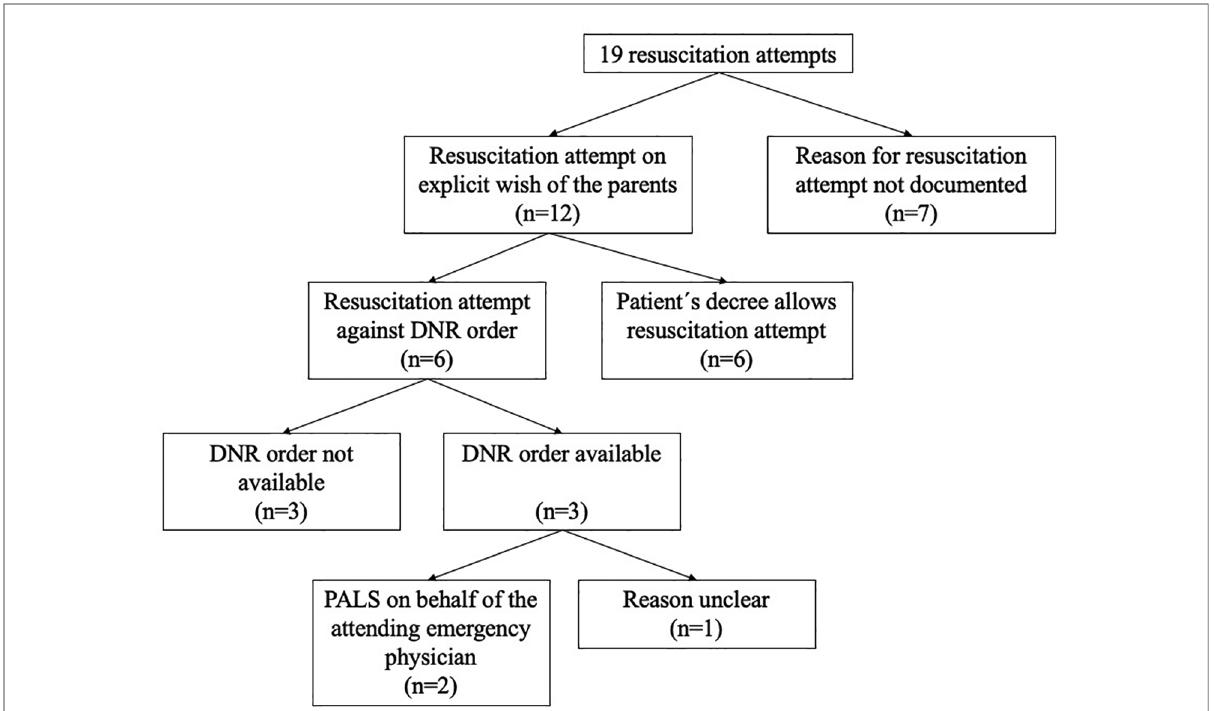
FIGURE 4 Flowchart demonstrating the decision-making for the resuscitation attempts. Abbreviations: CPR, Cardiopulmonary resuscitation; DNR, Do not resuscitate; PALS, Pediatric advanced life support.